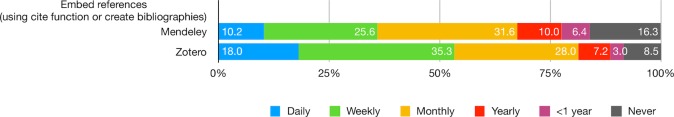
How often do you do the following re-using task on Mendeley?